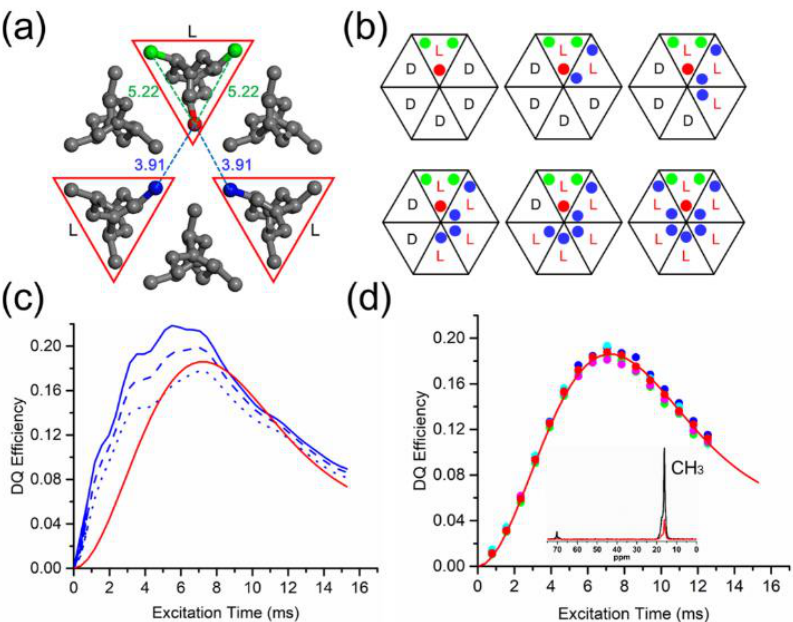
Figure 2. ( a ) R 3c packing structure and 13 C five spin systems of 13 C CH 3 labeled poly(L-lactic acid) (PLLA) in stereocomplex (SC), including reference (red) two intrastem (green) and two interstem spins (blue) at distance less than 7 Å used in calculations for the DQ curve. ( b ) Schematic drawing for six submodels in the P 3 model . ( c ) Calculated 13 C – 13 C DQ buildup curves based on R 3C (red solid) and P 3 models (blue) at blending ratios of PLLA/PDLA=7/3 (solid), 1/1 (dashed), and 3/7(dotted) with T 2 value of 9.5 ms. ( d ) 13 C CPMAS SQ (black) and DQ (red) NMR spectra for the 33% PLLA/PDLA blends at a blending ratio of PLLA/PDLA= 1/1, with an excitation time of 6.27 ms and DQ buildup curves for PLLA/PDLA SC at PLLA/PDLA blending ratios of 7/3 (pink filled circle), 6/4 (light blue), 5/5 (sky blue), 4/6(light green), and 3/7 (red) with the calculated curve for the R 3c model. (Reprinted with permission from ACS Macro Lett . 2018 , 7 , 667 – 671. Copyright (2018) American Chemical Society).